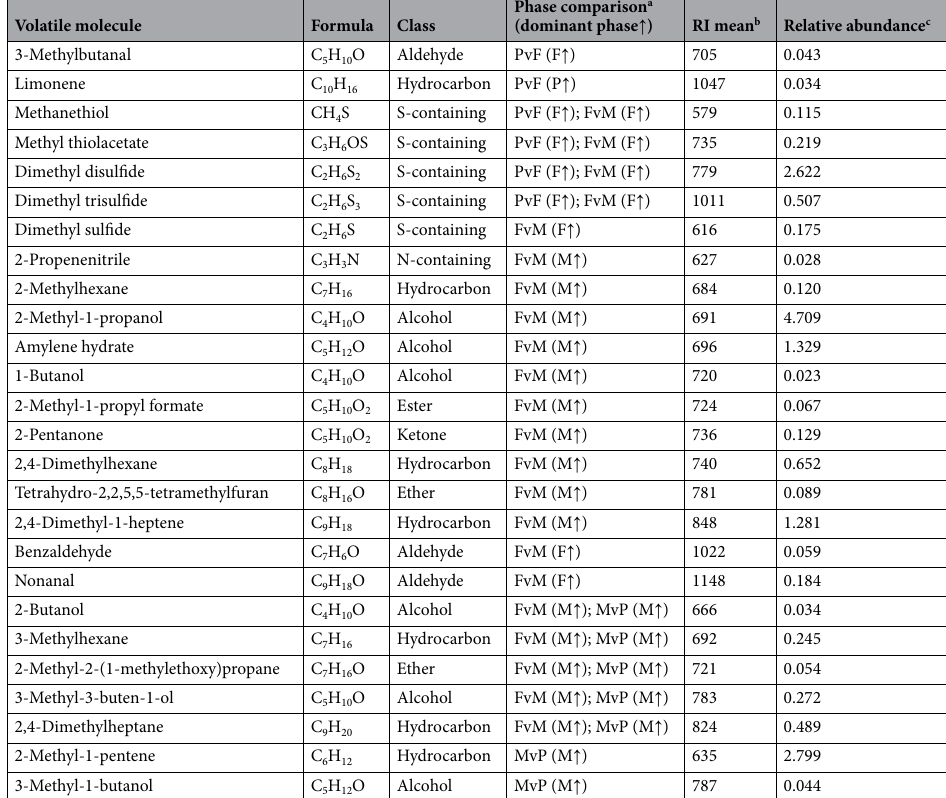
Table 1. Putatively identified volatile molecules that are statistically significantly different between the pre-flowering and the flowering phases. Data from 16 samples. Only peaks that were above the pre- defined detection criteria were included in the statistical calculations. a Statistically different volatiles in the pre-flowering versus the female flowering (PvF), the female versus the male (FvM), and the male versus the pre-flowering phases (MvP). The p -values were not corrected for multiple comparison adjustments. b Linear retention index was determined using C 8 –C 20 n ‐ alkane standard solution on a Rxi-624Sil (60 m × 250 μm × 1.4 μm) column. RI below 800 was extrapolated by ChromaTOF. c Relative abundance = analyte total peak area / total peak area of all analytes